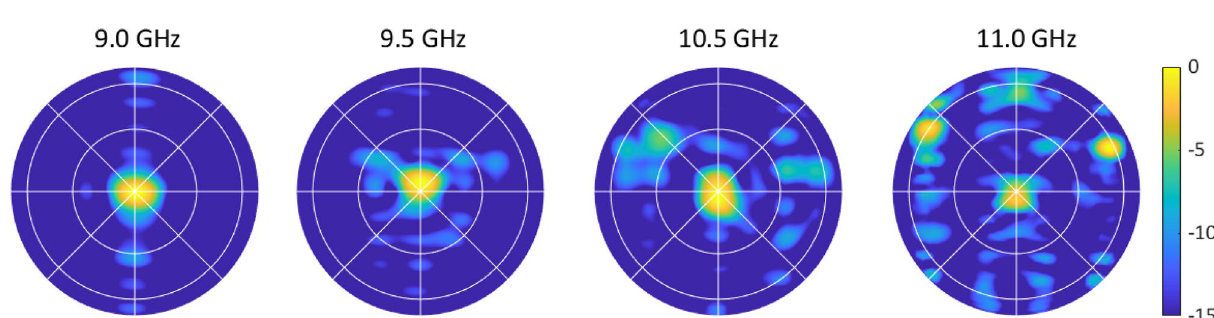
Figure 7. The radiation pattern of the metasurface antenna steering in azimuth ( φ = 0 ◦ ) and elevation ( φ = 90 ◦ ). ( a ) shows azimuth cross sections steered from − 60 ◦ to 60 ◦ in 15 ◦ increments. ( b ) shows the azimuth steering accuracy (with the dashed line showing the goal), indicating that the antenna can accurately steer from − 50 ◦ to 50 ◦ . ( c ) shows elevation cross sections steered from − 75 ◦ to 75 ◦ in 15 ◦ increments. ( d ) shows the elevation steering accuracy (with the dashed line showing the goal), indicating that the antenna can accurately steer from − 70 ◦ to 70 ◦ .